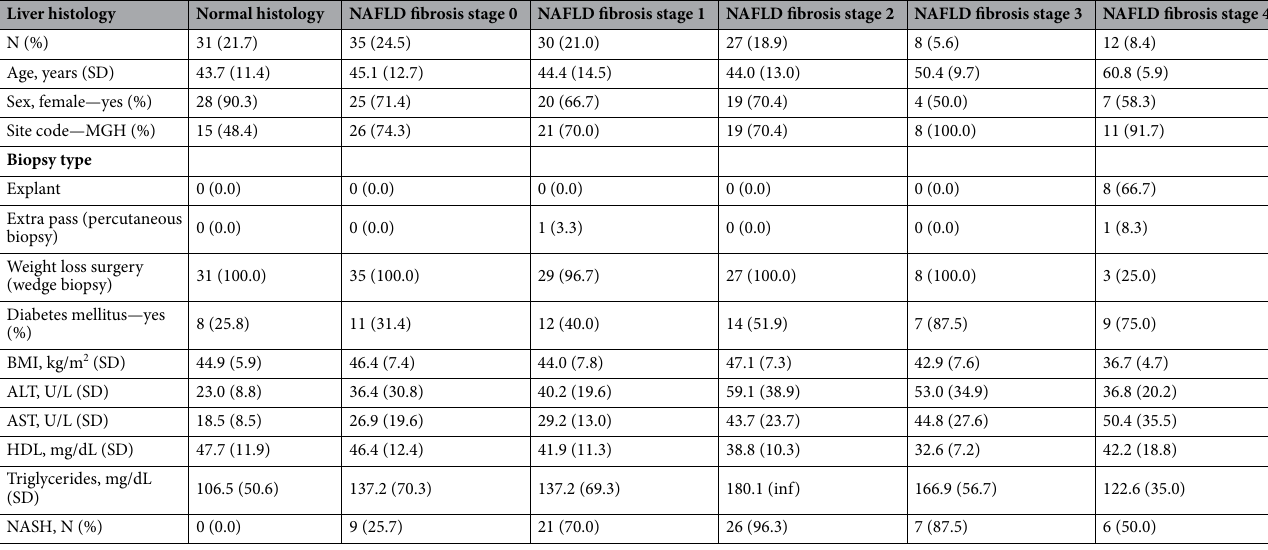
Table 1. Characteristics of the patient